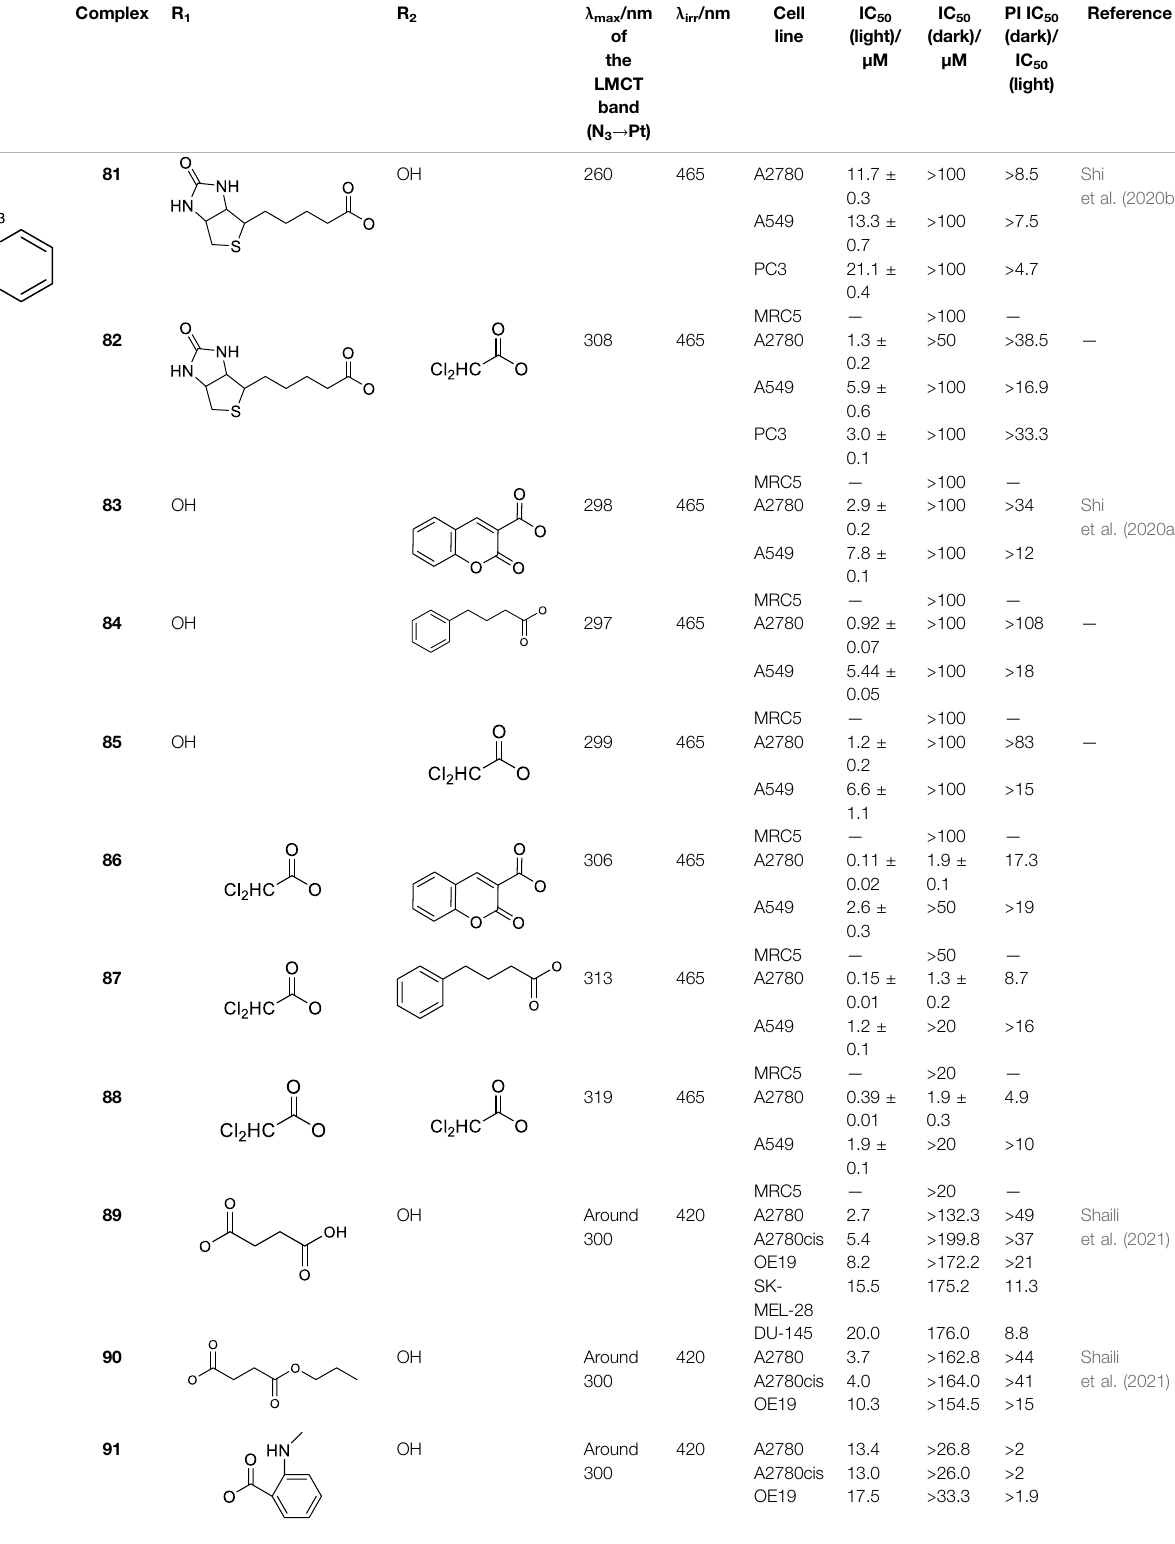
TABLE 8 | Chemical structures of complexes 81 – 94 and IC 50 values of complexes toward different cell lines.